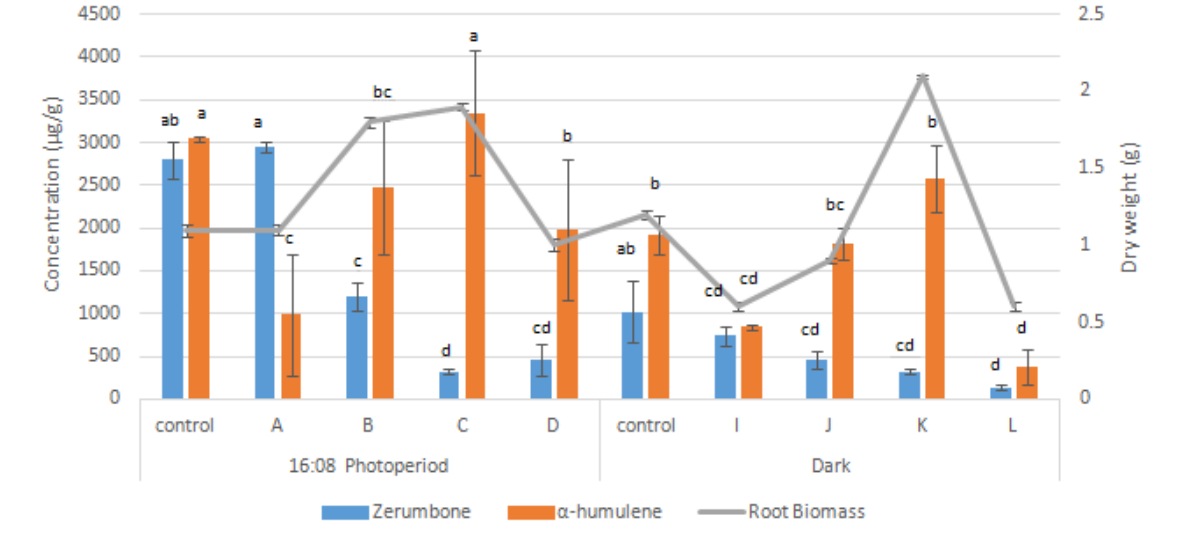
Figure 4. Zerumbone, α -humulene, and root dry weight produced in a combined auxin–auxin medium with a 16:08 photoperiod and dark condition. MS media supplemented with 1 mg/L NAA (control) combined with 1, 3, 5, and 7 mg/L IBA (treatments A, B, C, and D, respectively, with a 16:08 photoperiod) or with 1 mg/L NAA (control) combined with 1, 3, 5, and 7 mg/L IBA (treatments I, J, K, and L in the dark, respectively). Error bars indicate standard deviation of the mean value. Means with different letters in the same column are significantly different at p < 0.05 according to ANOVA and Tukey’s multiple range test.